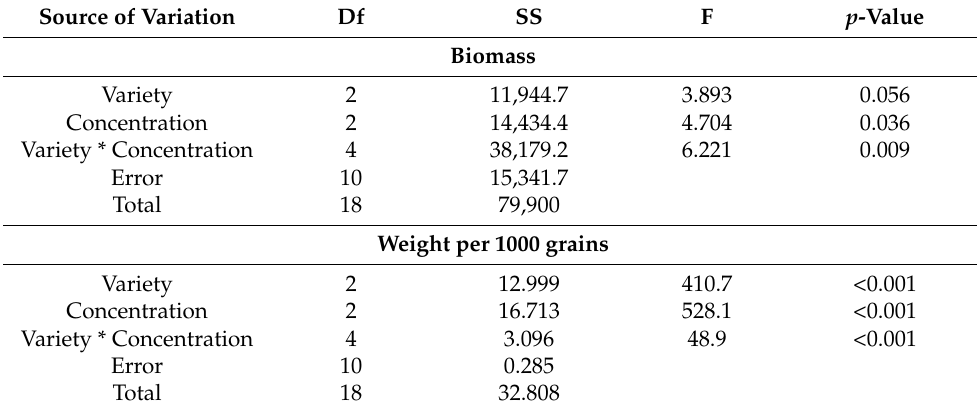
Table 1. Factorial ANOVA for biomass and weight per 1000 grains of commercial varieties when exposed to soils containing different Hg